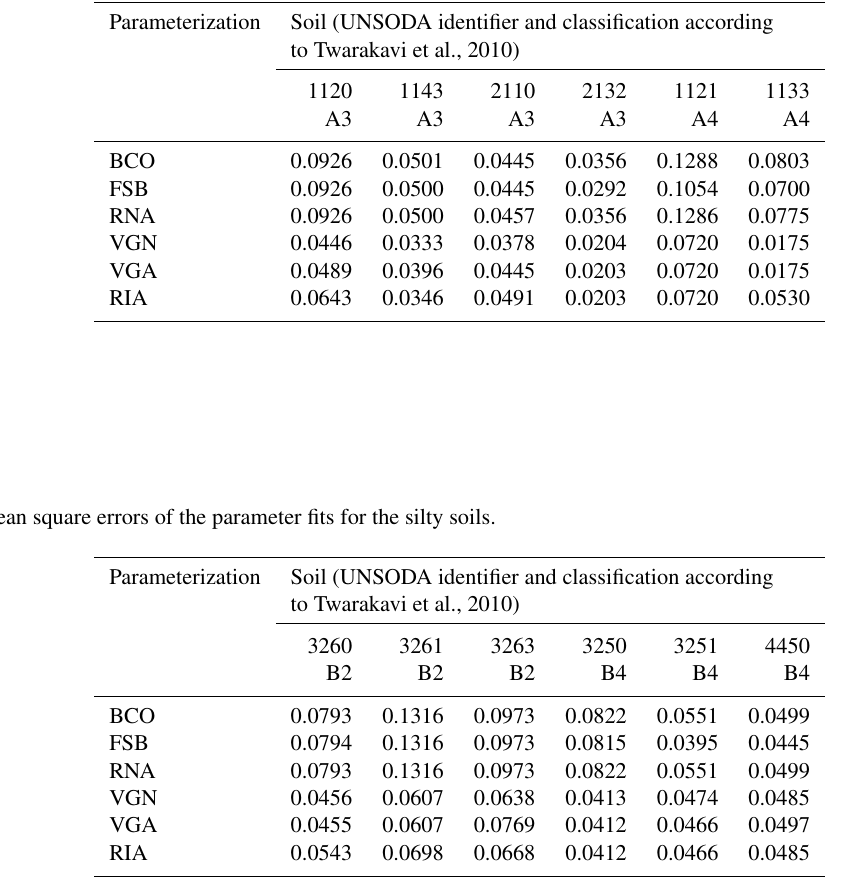
Table C6. Root mean square errors of the parameter fits for the sandy soils (A3 and A4 soils, according to Twarakavi et al., 2010).